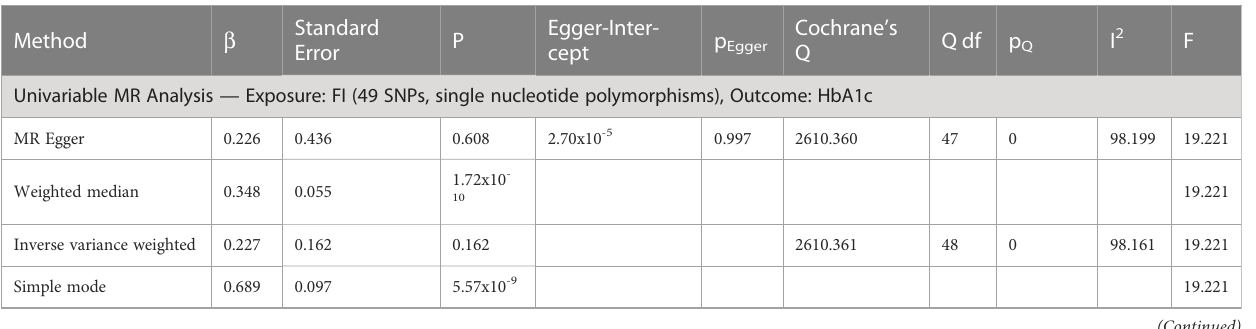
TABLE 4 Univariable MR analyses of fasting insulin (FI) and glycated hemoglobin (HbA1c) as outcome followed by multivariable MR adjusted for elevated fasting glucose (FG), type 2 diabetes (T2D) and increased hemoglobin